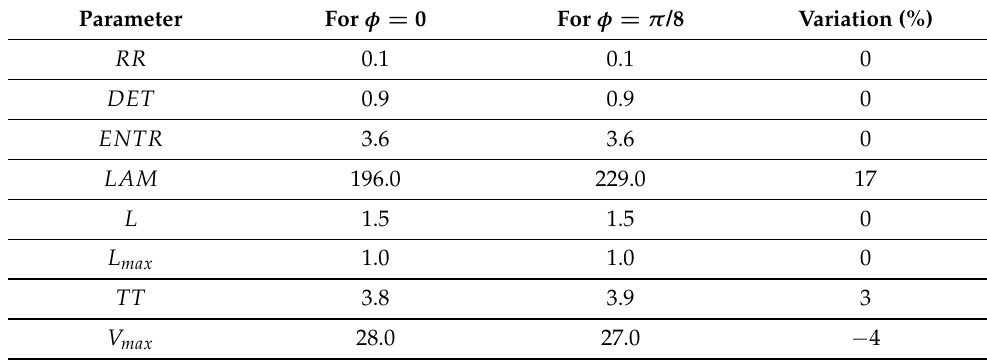
Table 2. RQA quantification of the multiple asynchronous function with different phase